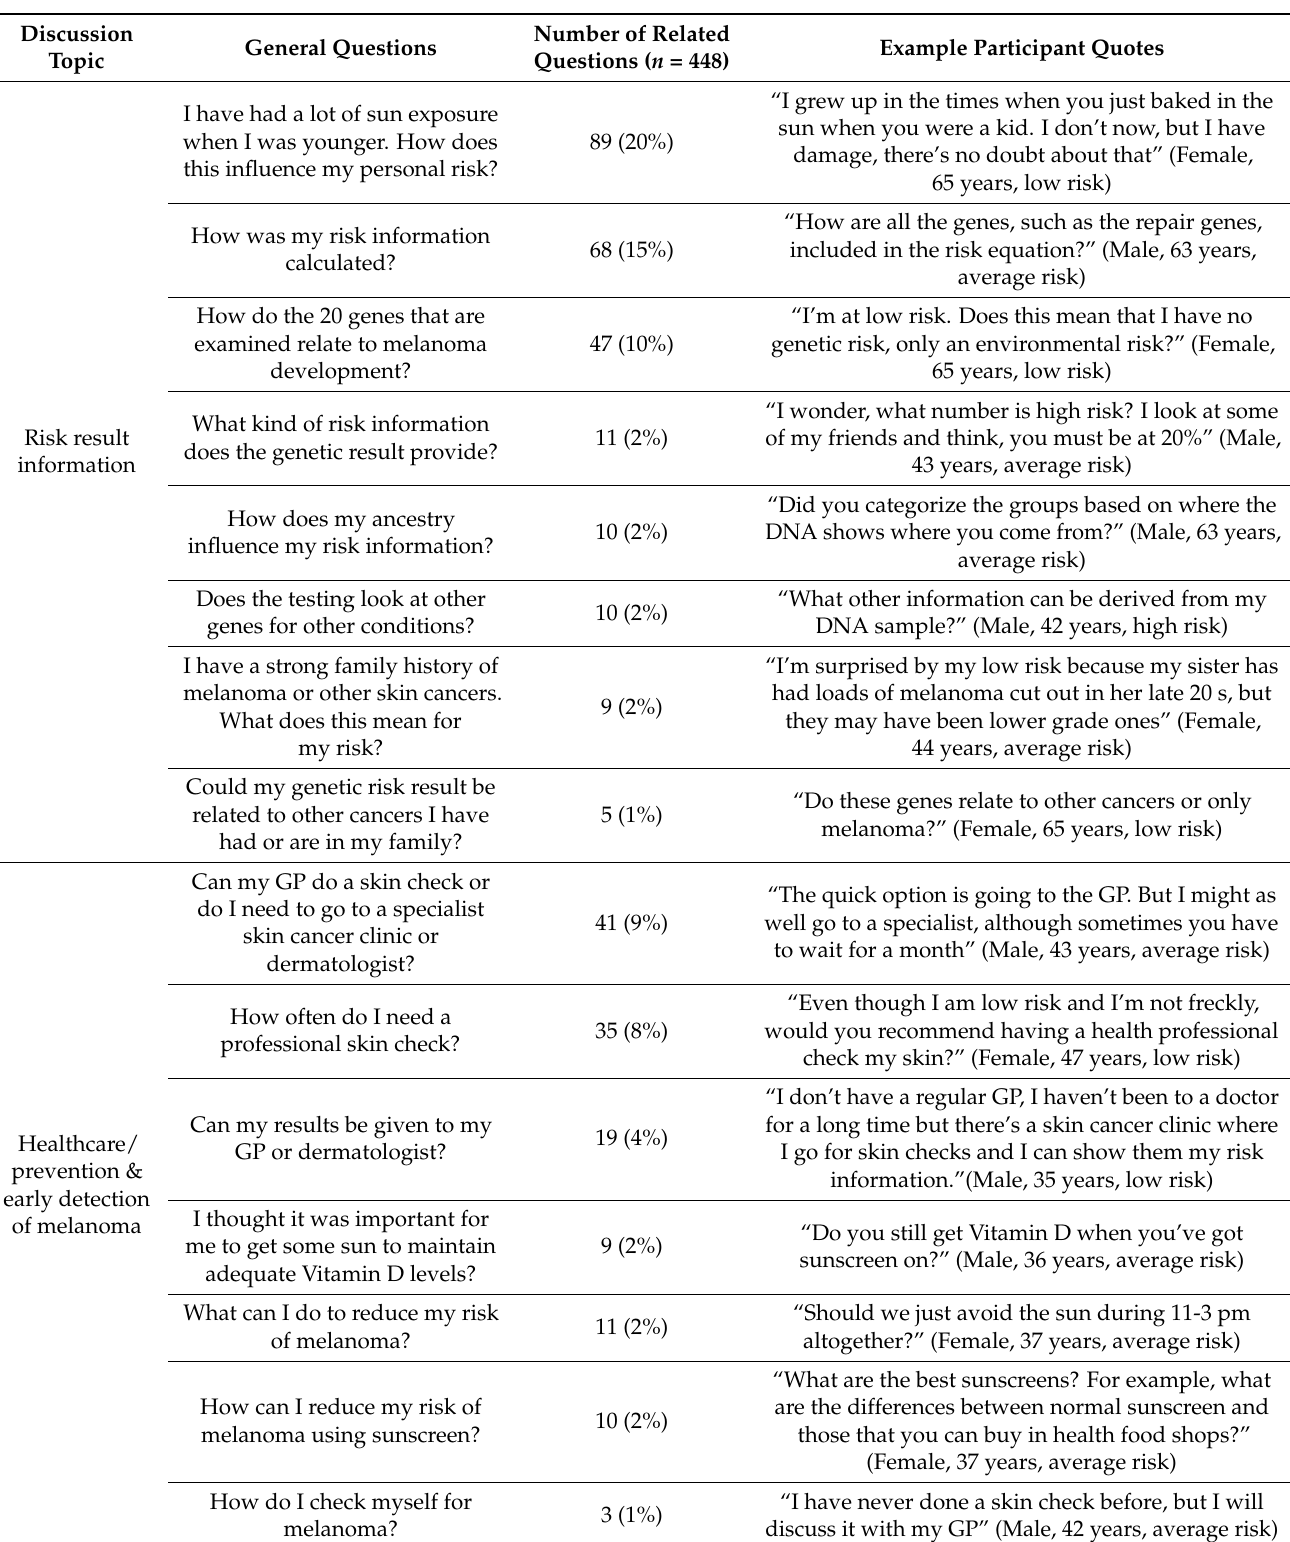
Table 3. Participant questions grouped by topics, for those who spoke with the genetic counselor via